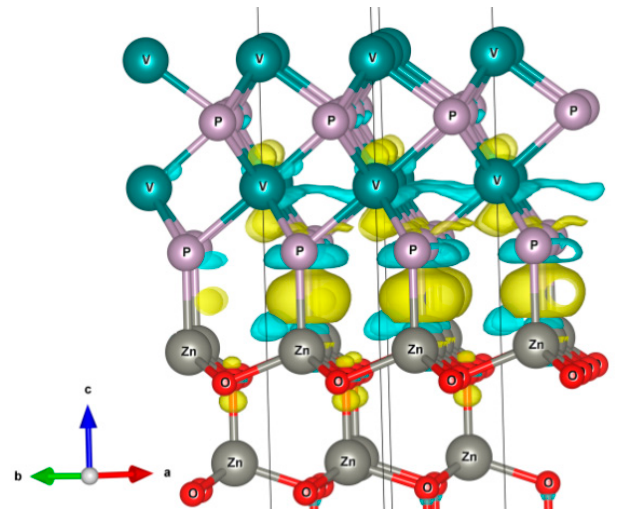
Figure 7. Charge density distribution in V 2 P 2 /ZnO composite. Blue and yellow areas correspond to the lack and excess of charge, respectively.